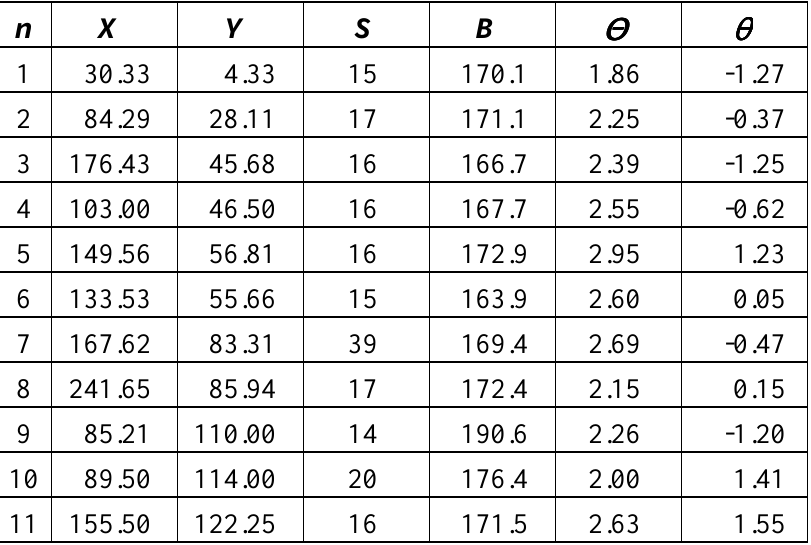
Table 1. Example of ant image identification